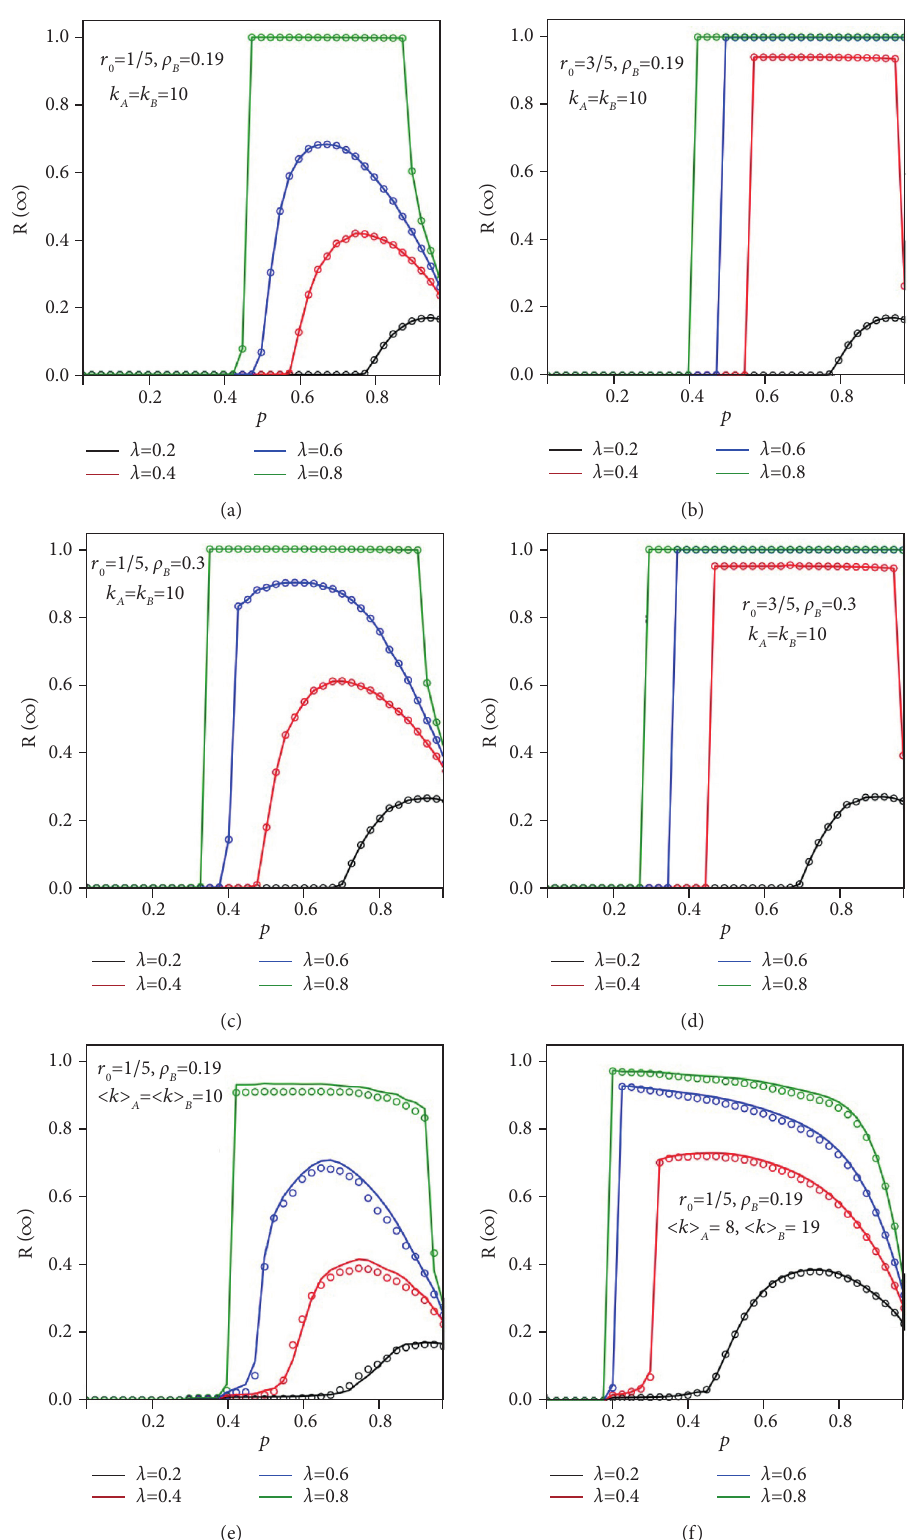
Figure 5: The change of spreading size R ( ∞ ) versus contact probability p of homogeneous individuals. (a–d) The individuals’ degree distribution satisfies k A � k B � 10, where (a) r of k A � k B � 10, where r lines represent theoretical prediction results. Other parameters: N � 10000, I B � 5, T � 5, c � 1, ε